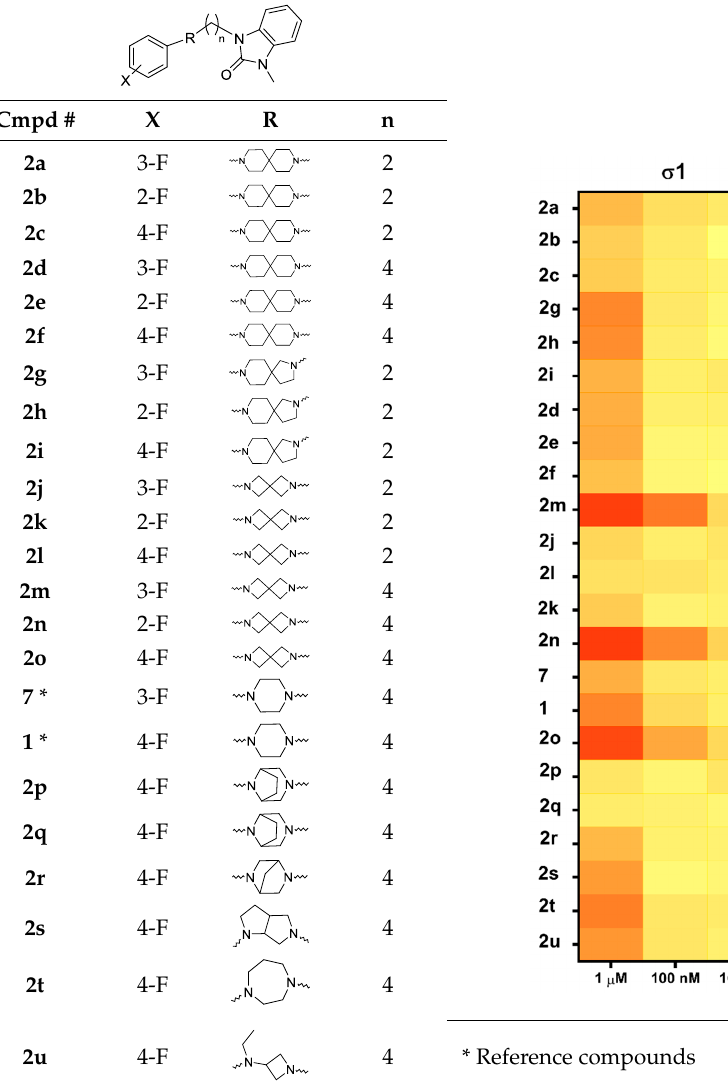
Table 1. In vitro screening assay to identify hit compounds.